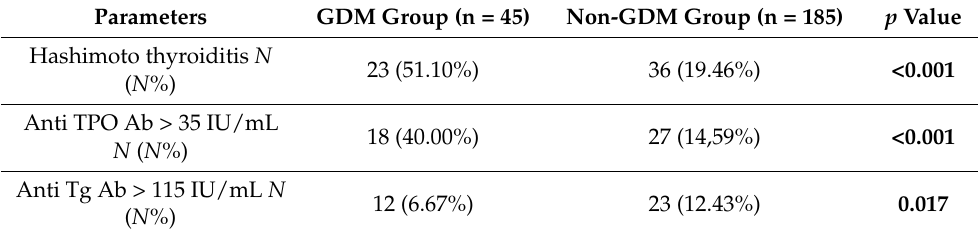
Table 6. The prevalence of antithyroid antibodies in the study population.